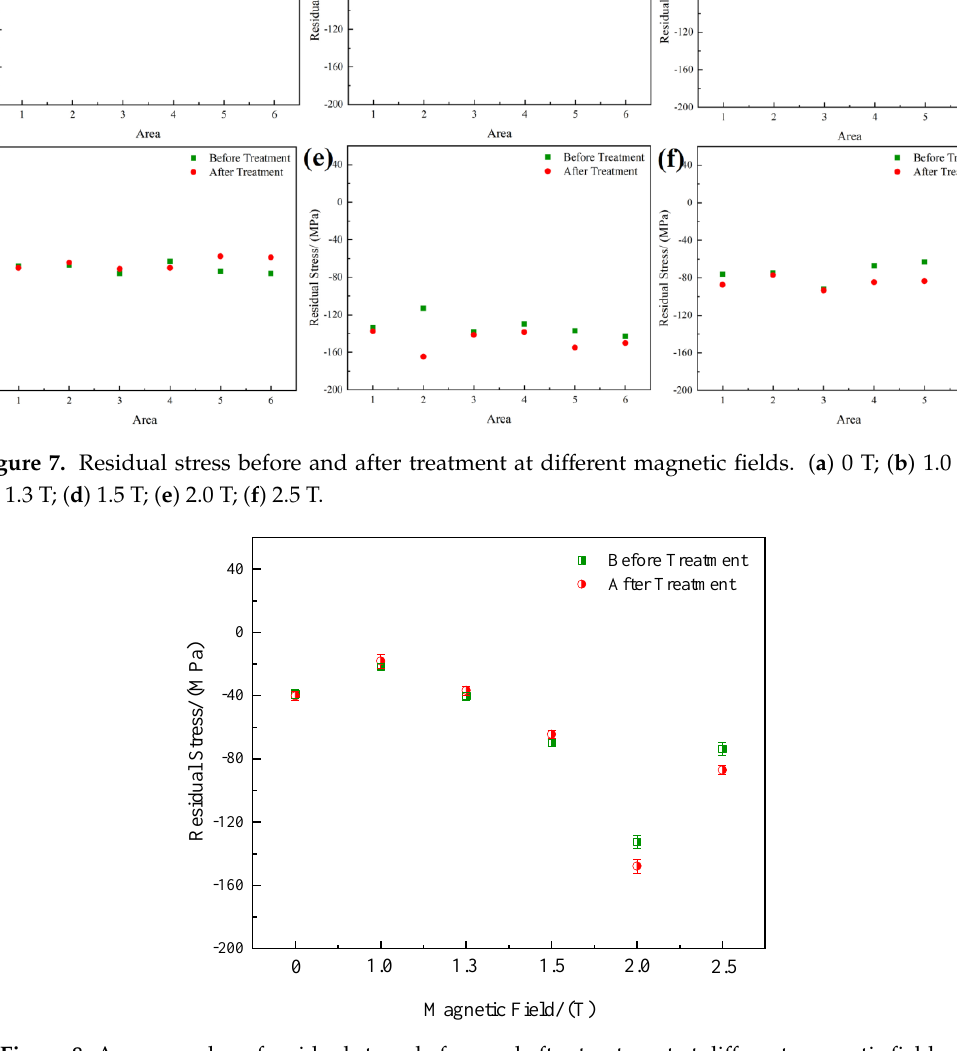
Figure 8. Average value of residual stress before and after treatment at different magnetic fields.